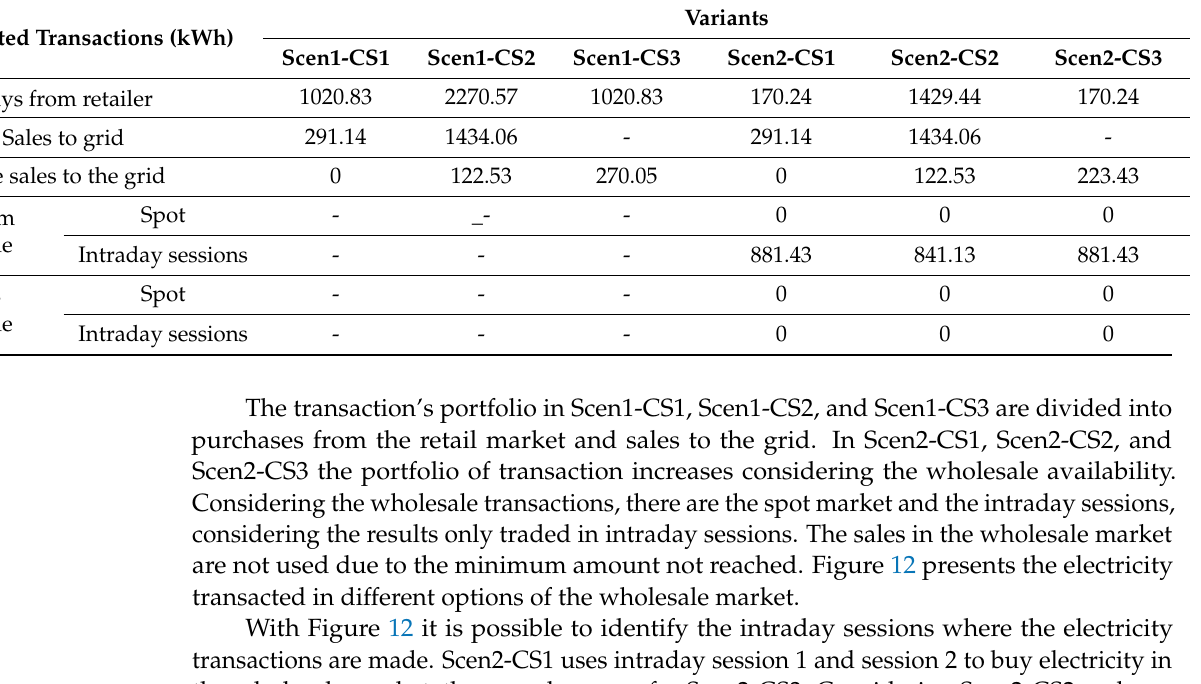
Table 3. Portfolio of Electricity transactions in different markets for the energy